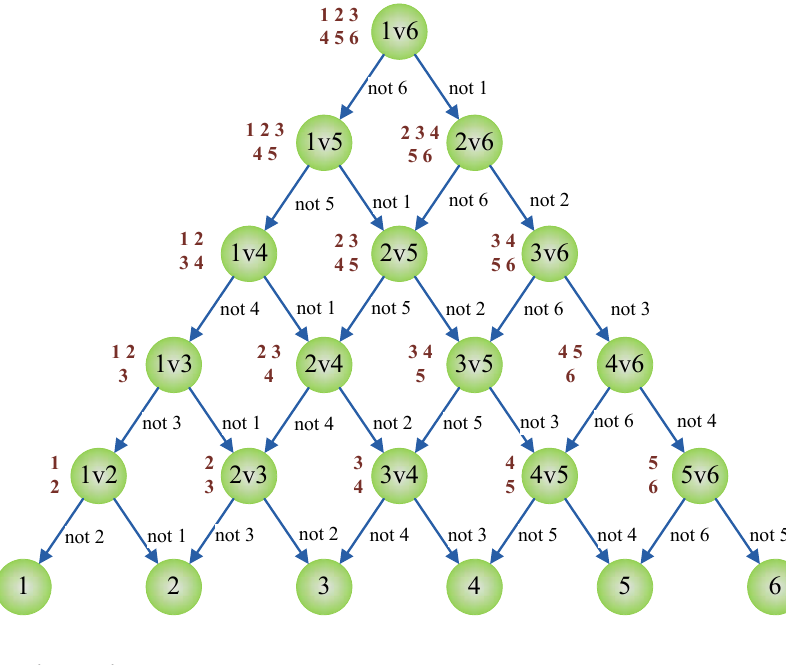
Figure 5. The DAG for finding best class out of six classes.